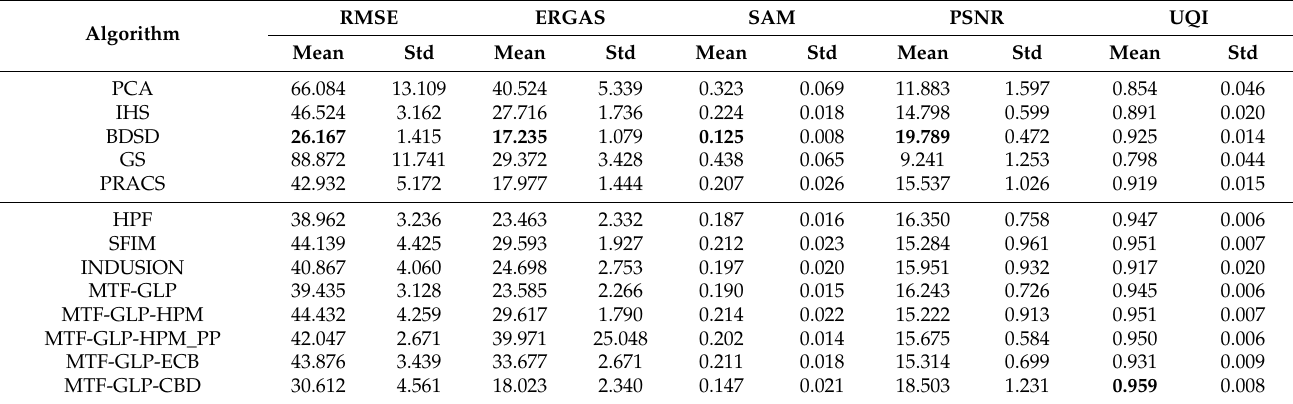
Table 2. Quality indices for the False Colour Thermal Pansharpened images of the Illescas UAV dataset for each pansharp- ening algorithm tested.